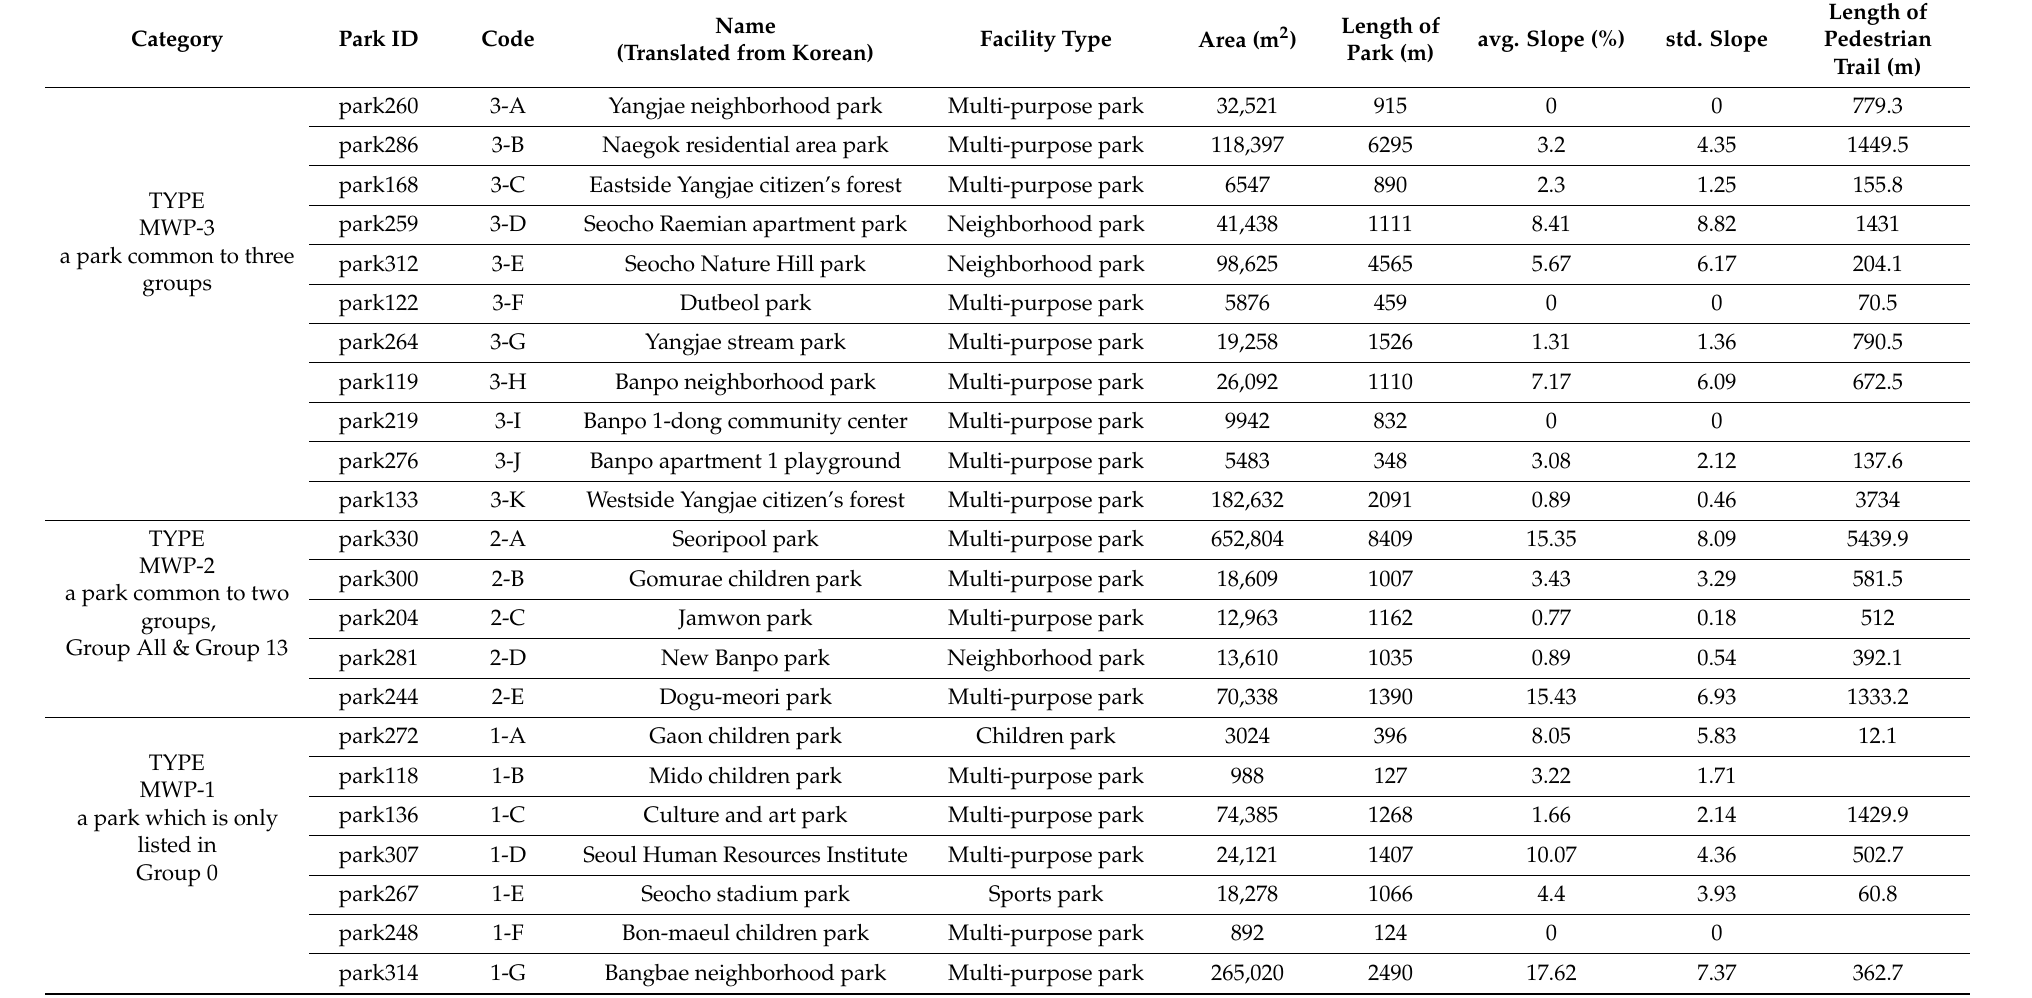
Table 6. List of three types of ‘mostly walked parks’ (from Seoul Urban GIS